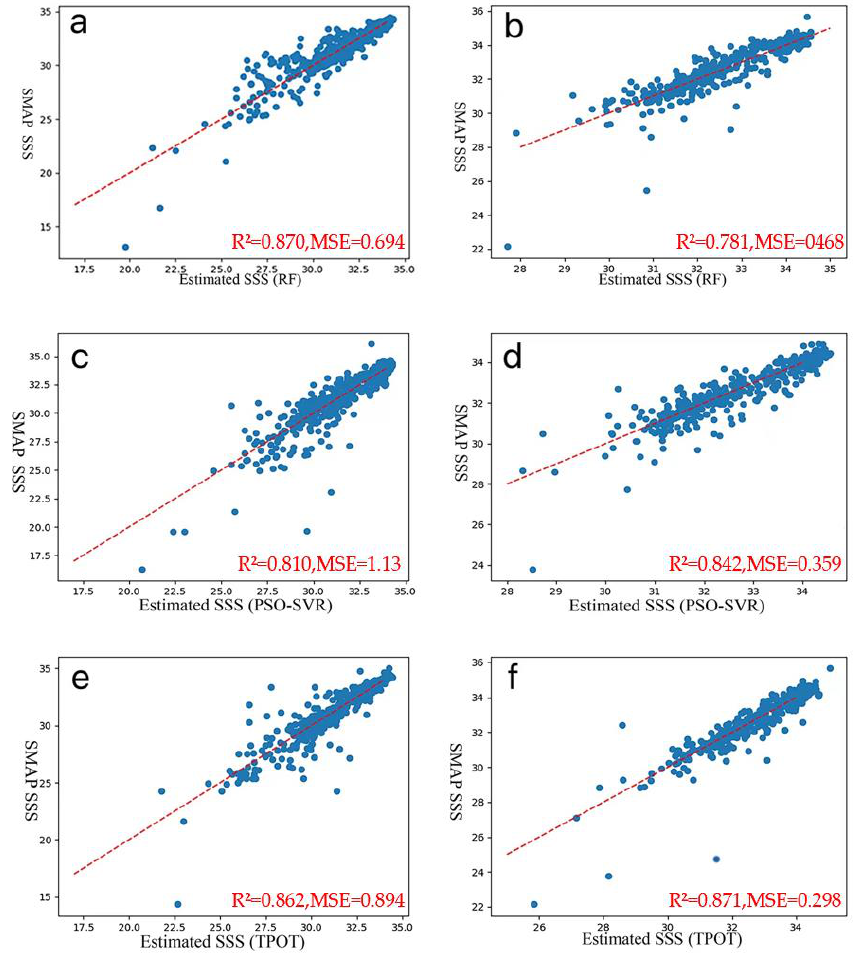
Figure 5. Accuracy validation of Random Forest (( a ): August; ( b ): March), PSO-SVR (( c ): August; ( d ): March), TPOT (( e ): August; ( f ): March). Both horizontal and vertical coordinate units are